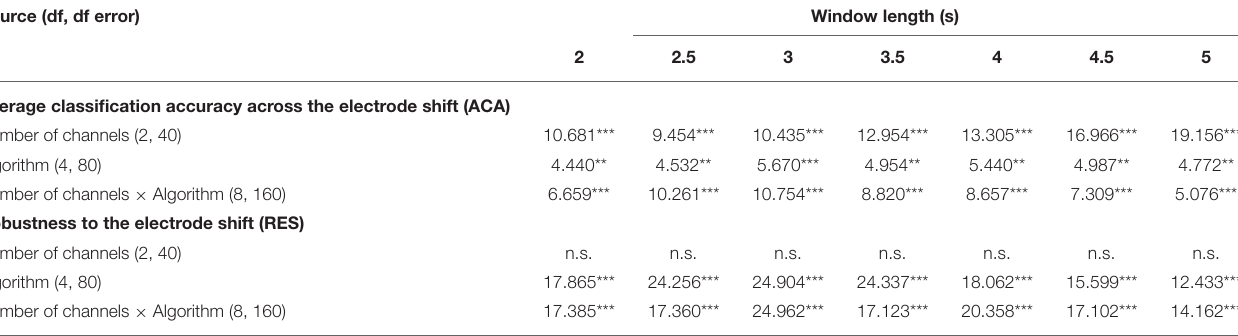
TABLE 1 | Results of the two-way repeated-measures ANOVA with two factors of “Number of channels” and “Algorithm” for various window lengths. Source (df, df error)